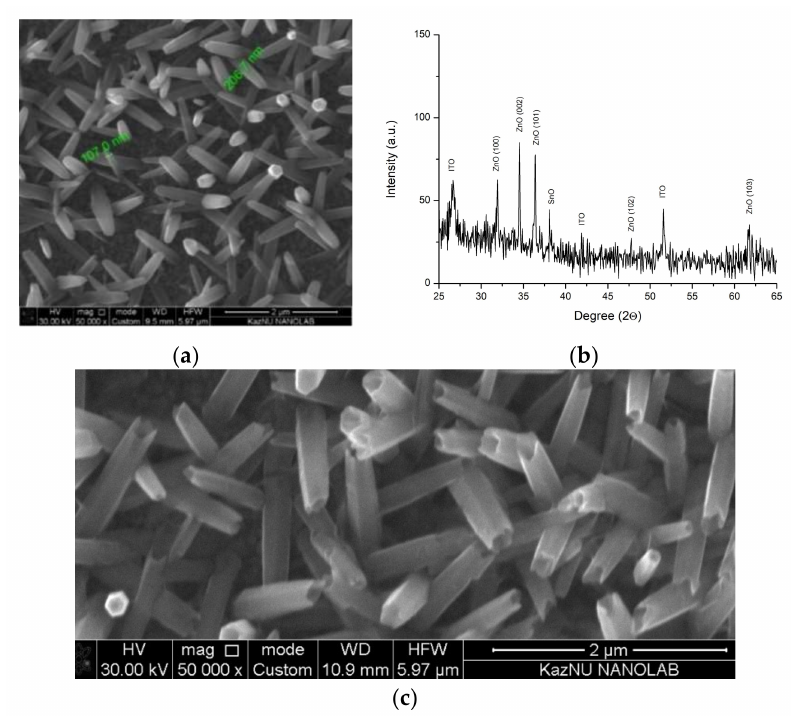
Figure 1. ( a ) NRs SEM image, ( b ) X-ray pattern of arrays obtained, ( c ) NTs SEM